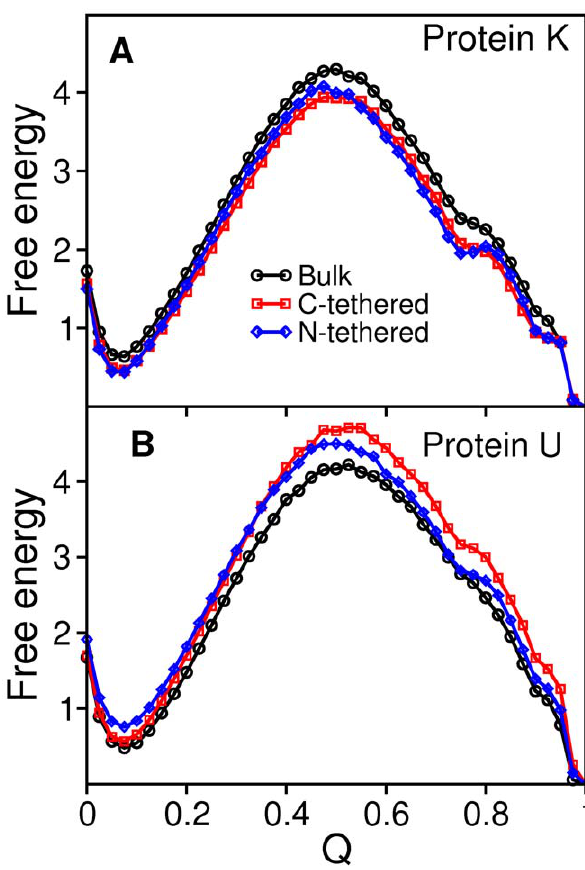
Figure 5. The folding rate for protein K and protein U in the considered folding setups evaluated at T m .